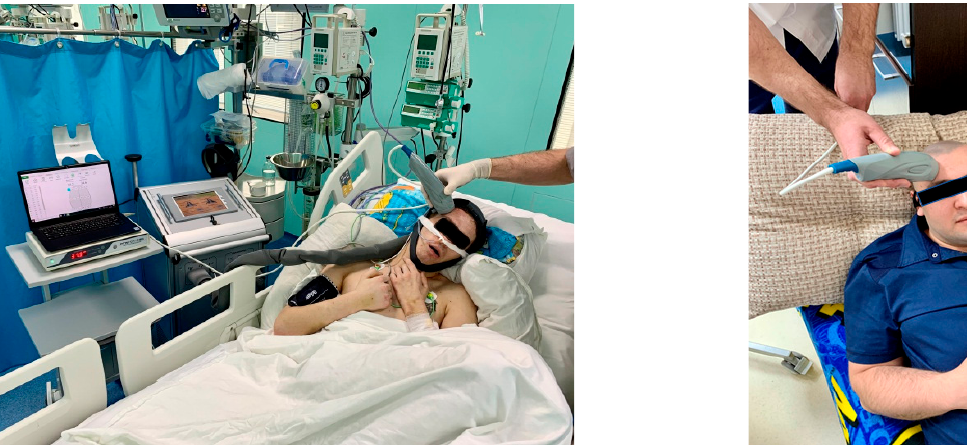
Figure 3. Using the MWR2020 (former RTM-01-RES) antenna in the projection of the left frontal lobe, the internal temperature of the cerebral cortex is being measured in patients with DOC ( a ) and healthy individuals ( b ).